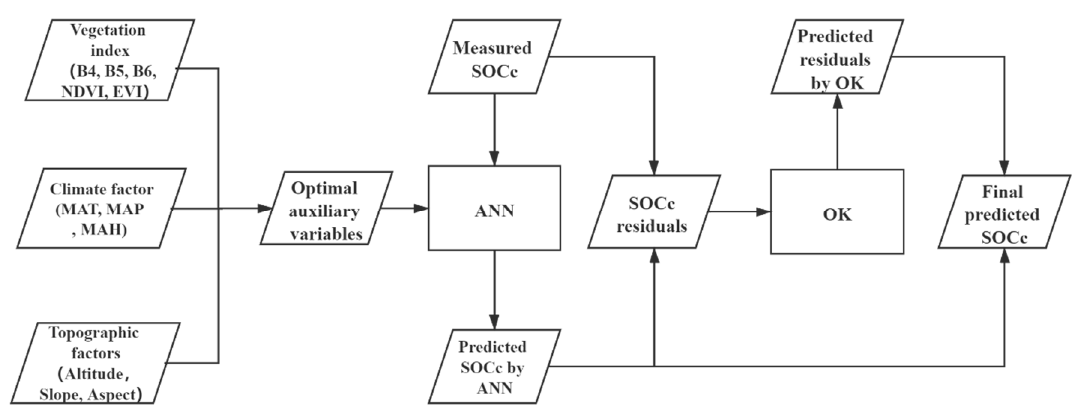
Figure 3. Flow diagram of wetland soil organic carbon concentration (SOCc) prediction by combining an artificial neural network (ANN) and ordinary kriging (OK).